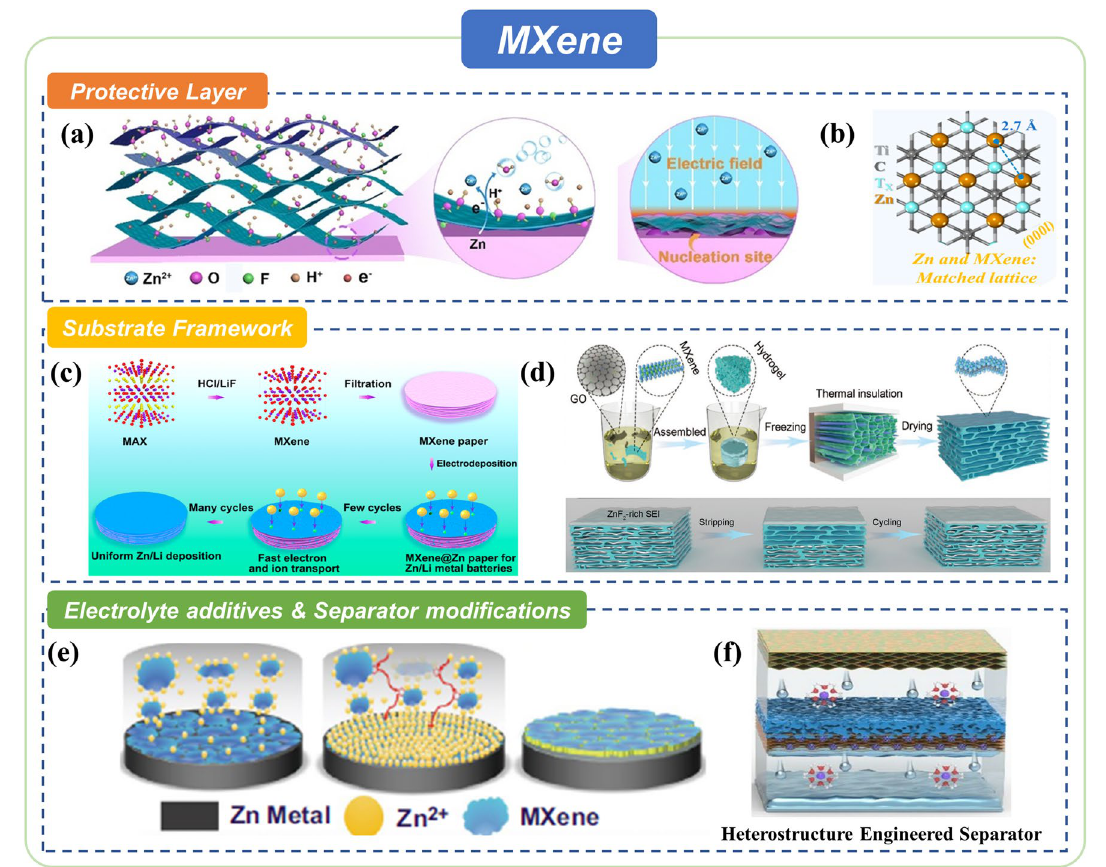
Fig. 6 Summary of MXene strategies for advanced Zn anode. a Self-assembled MXene on Zn Anode. Copyright 2020, Wiley. b MXene with high lattice match to deposited Zn. Copyright 2021, American Chemical Society. c A freestanding MXene@Zn paper. Copyright 2019, Ameri- can Chemical Society. d Hybrid MXene/praphene aerogel. Copyright 2021, Wiley. e Flexible MXene/nanocellulose hybrid film. Copyright 2022, American Chemical Society. f Zincophilic MXene/nanoporous oxide heterostructure engineered separator for ZIBs. Copyright 2022, American Chemical